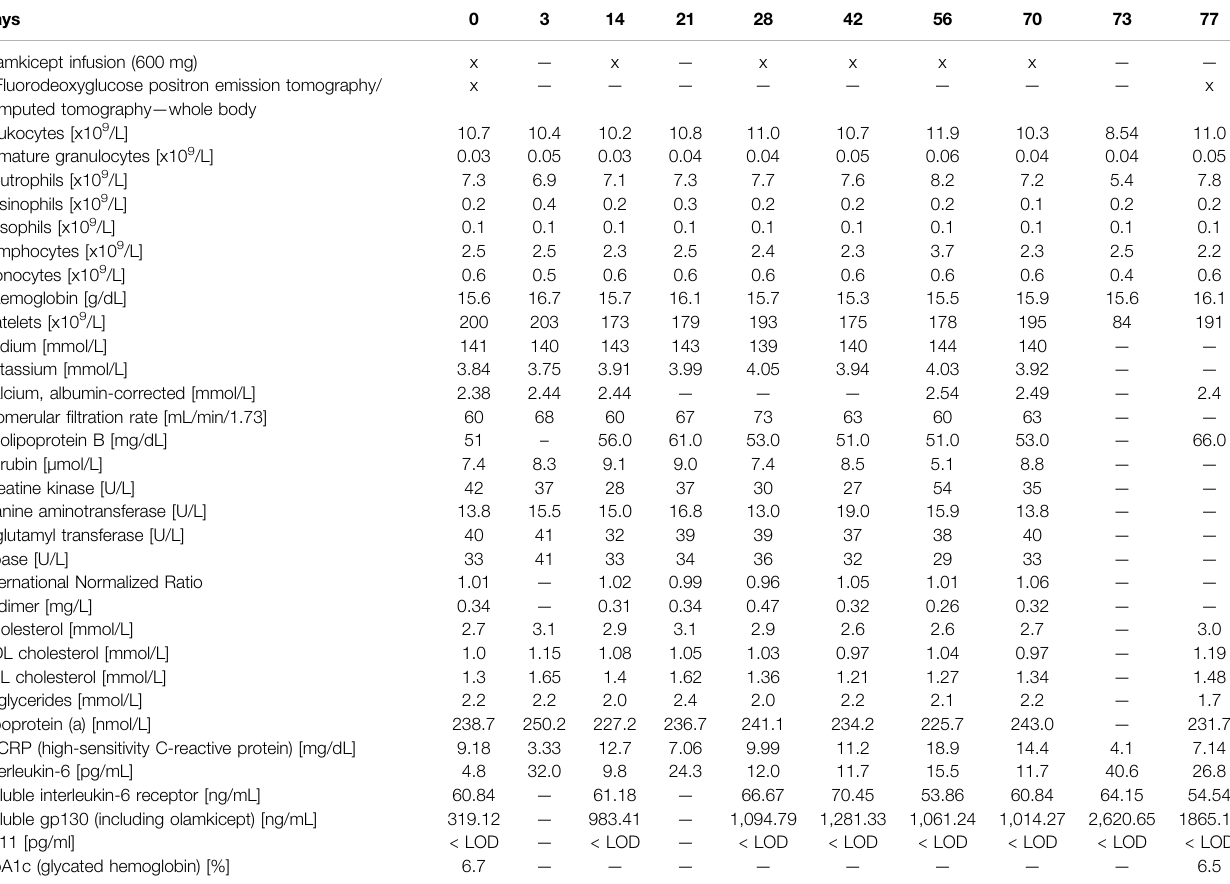
TABLE 1 | Patient ’ s characteristics, treatment and diagnostics. Days